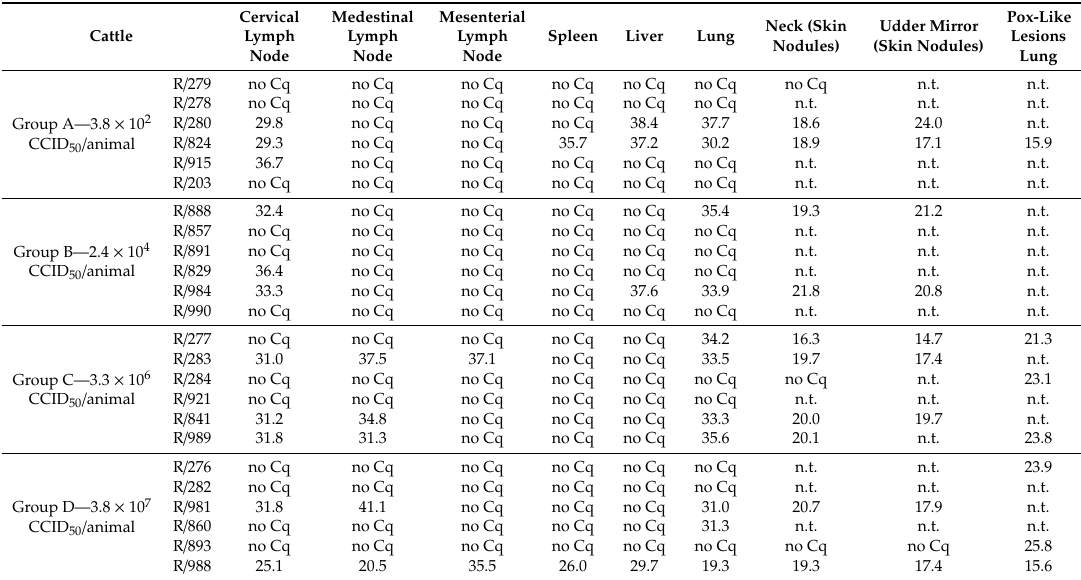
Pox-Like Lesions Lung